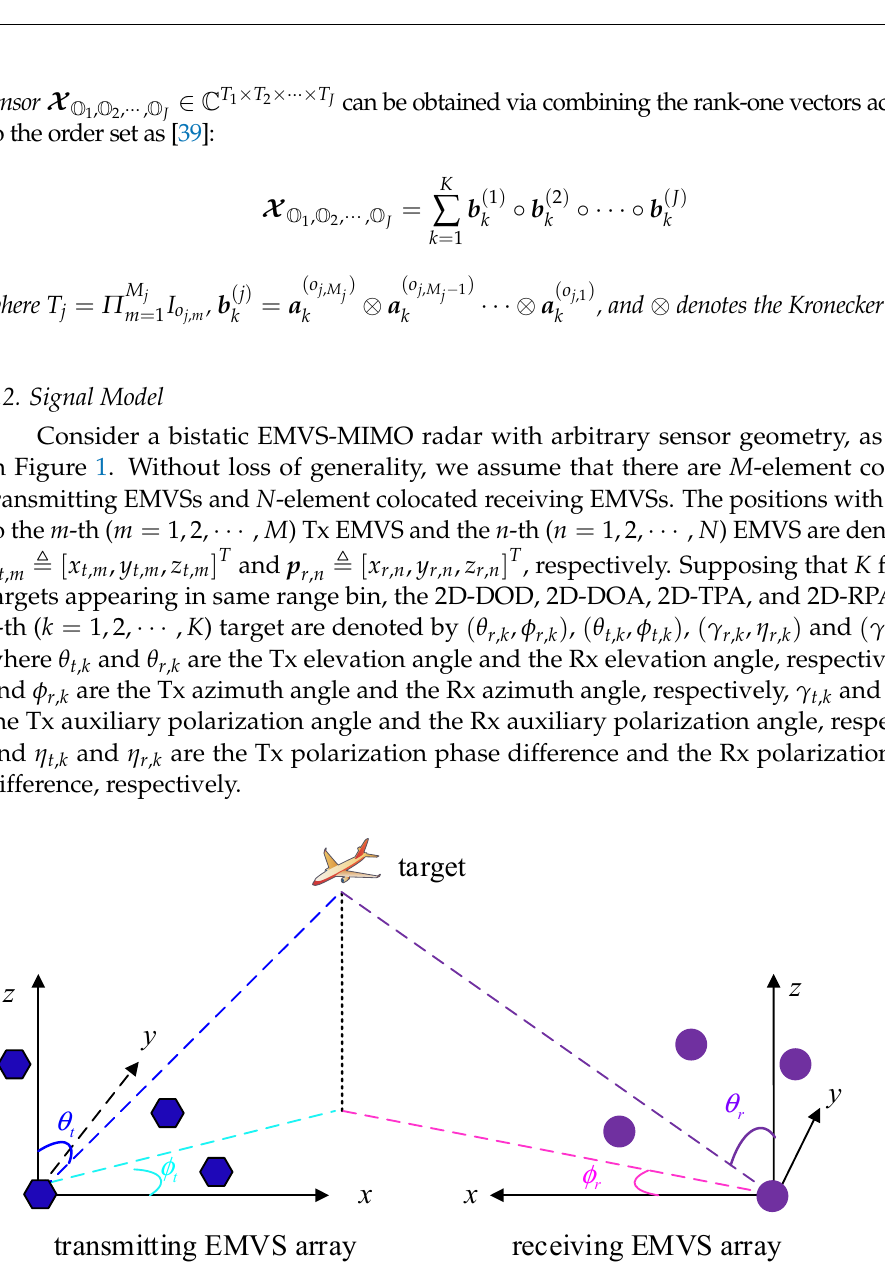
Figure 1. Schematic diagram of the bistatic EMVS-MIMO radar with arbitrary geometry .